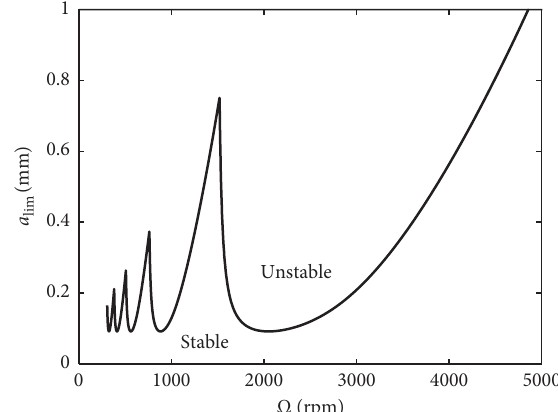
Figure 3: Stability lobe diagram of the cutting system with composite cutting tool (L/d � 10, c � 0.3, θ � 0 °